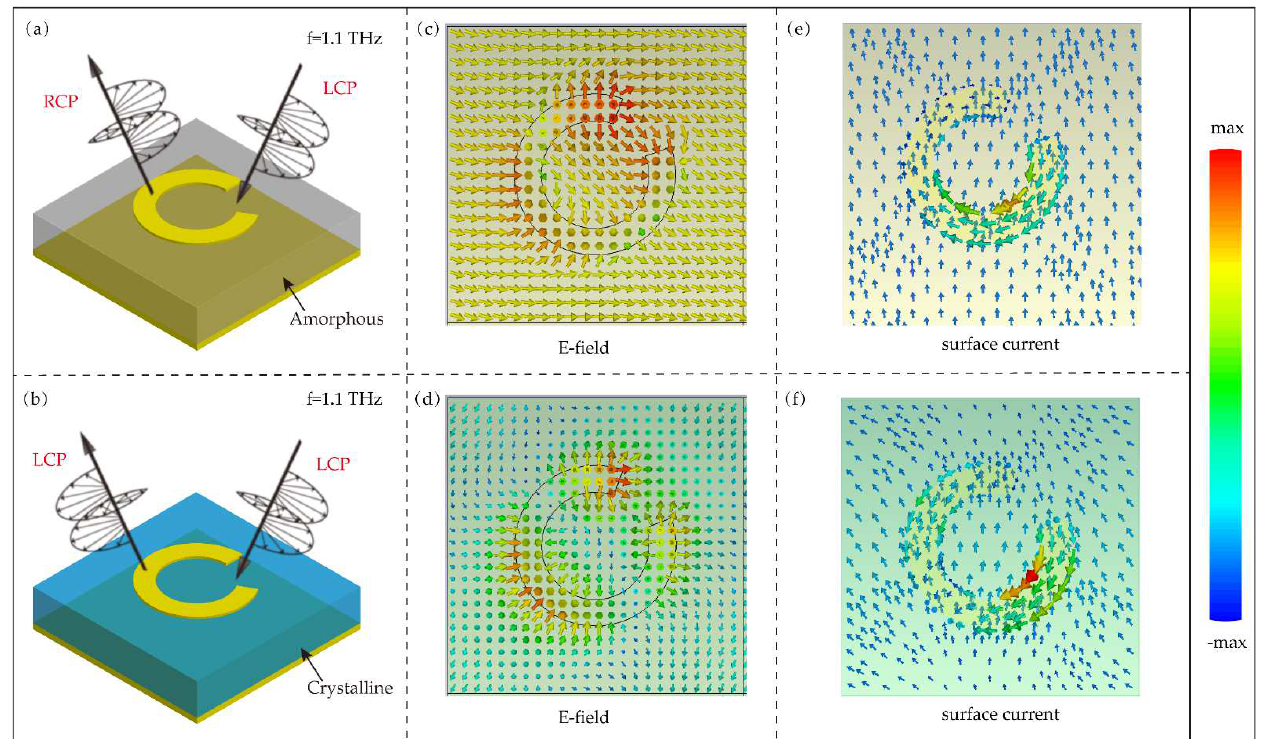
Figure 5. ( a , b ) The schematic diagram of opposite electromagnetic responses of unit cell in amorphous and crystalline states. ( c , d ) The top view of the electric field Ex distributions under the illumination of LCP in amorphous and crystalline states. The arrows represent the direction of the electric field. ( e , f ) The top view of the surface currents distributions under the illumination of LCP in amorphous and crystalline state. The arrows represent the direction of the surface